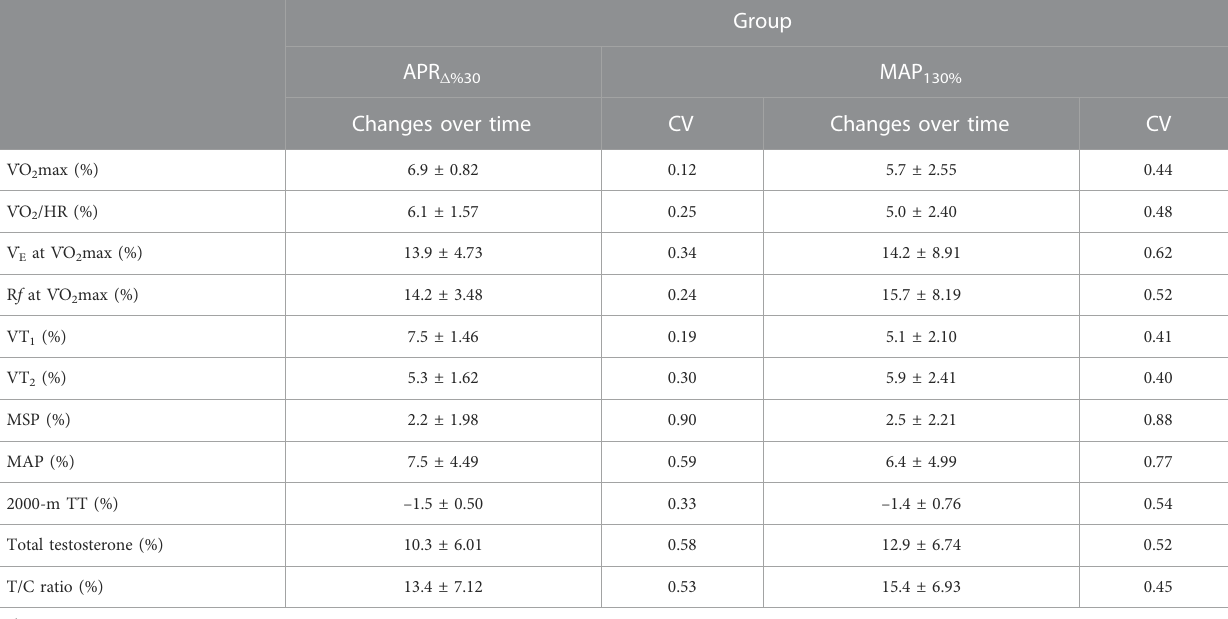
TABLE 2 The inter-individual variation (CV) of percent changes in hormonal and physiological variables as well as 2000-m rowing ergometer